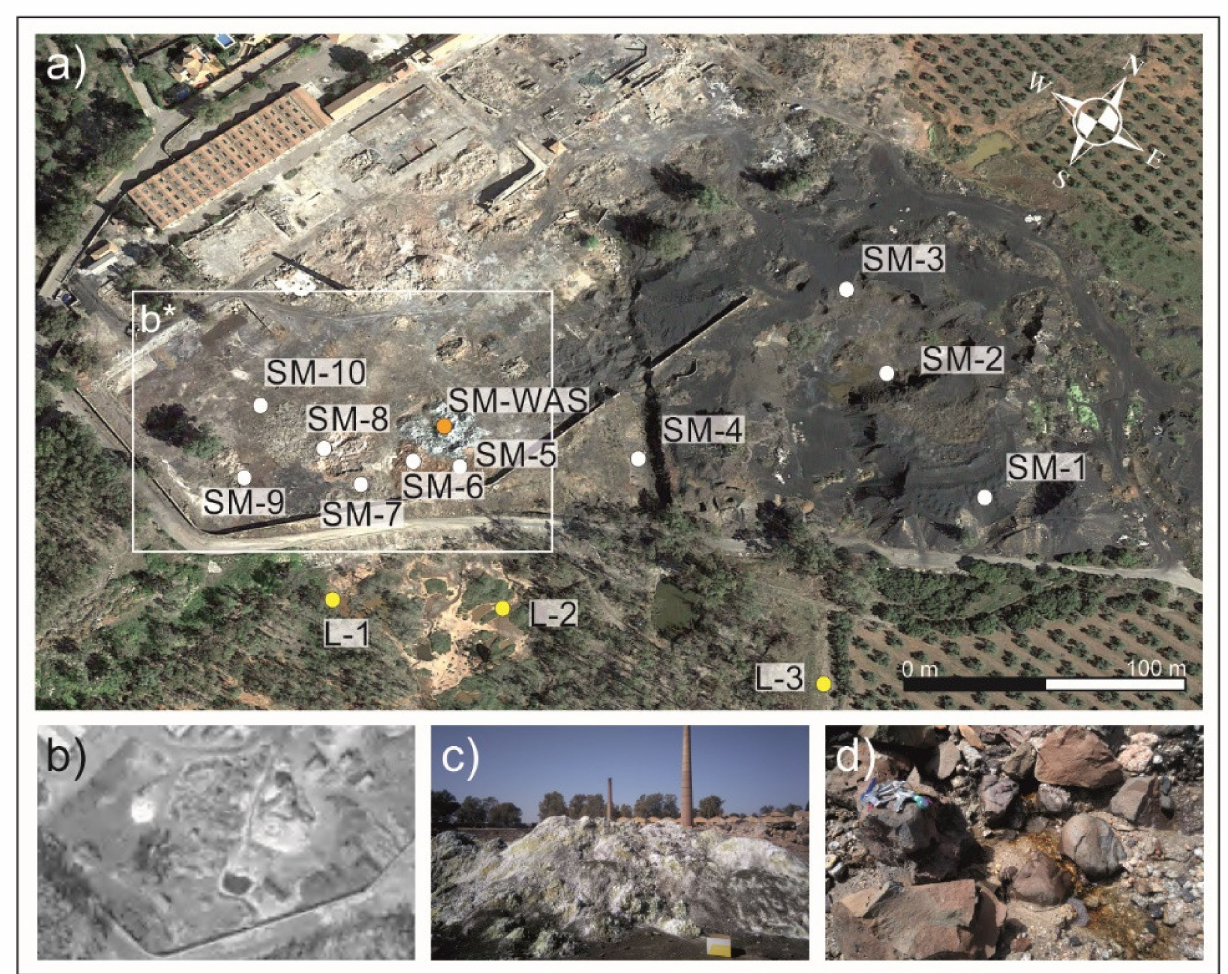
Figure 2. Images of the La Cruz smelter. ( a ) Aerial photograph of the facility (Google Earth, 2016) showing the location of different sampling points within and around the smelter. ( b ) Aerial photograph that was taken in 1984 of the area impacted by facility wastes. ( c ) Facility wastes (sample SM-WAS). ( d ) Leachate from the foot of the